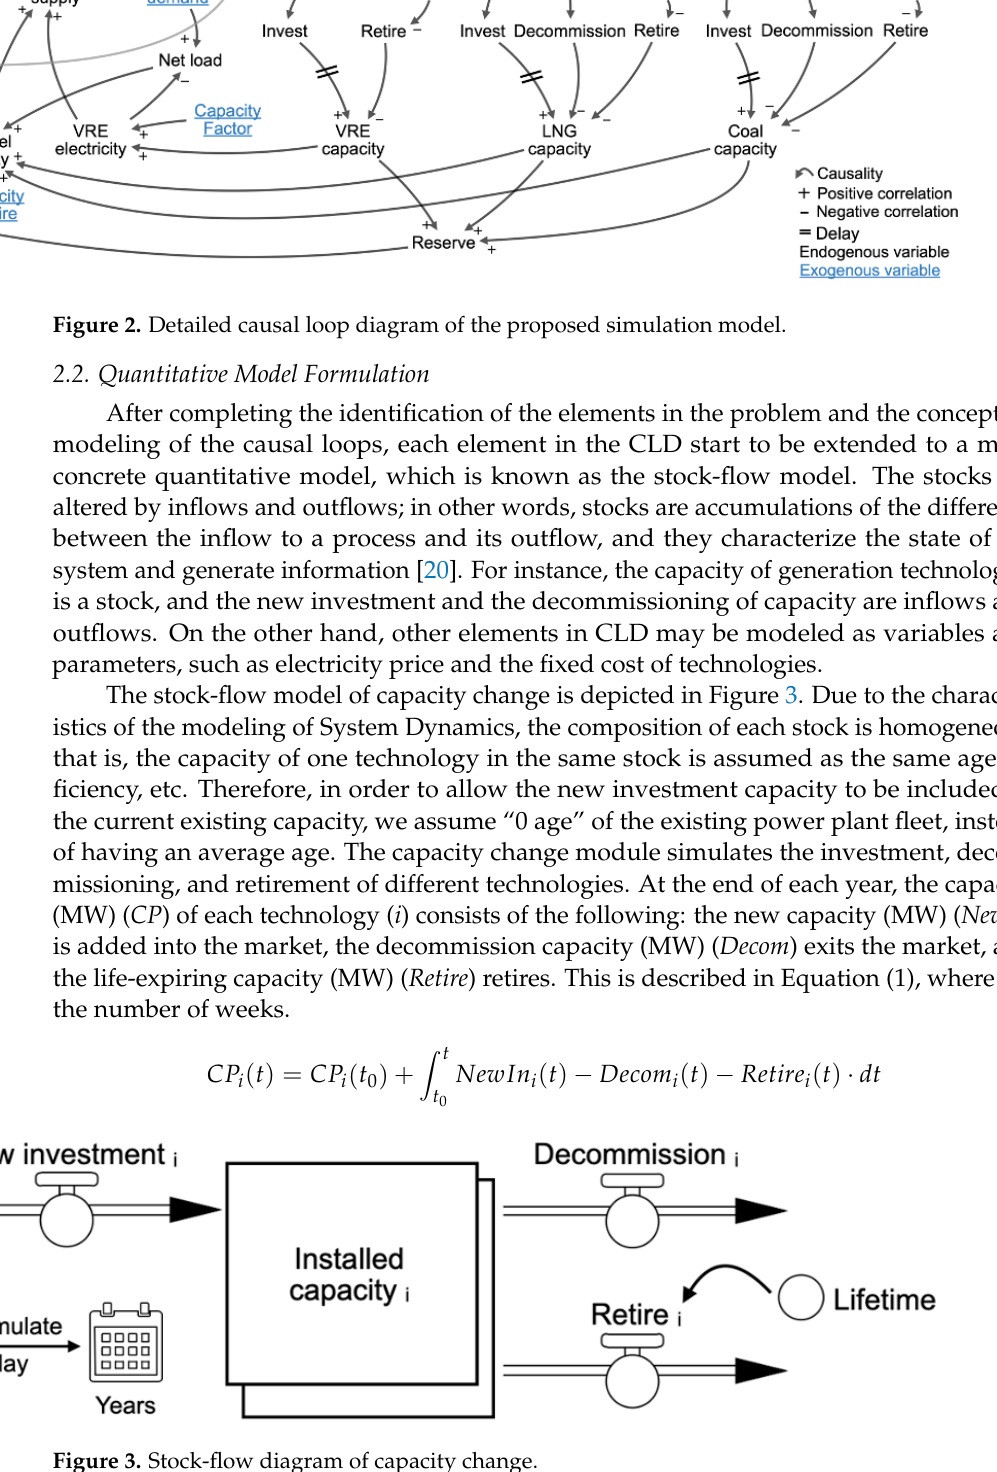
6 of 26 Table 1. Comparison of the three technologies characteristics. Power Output